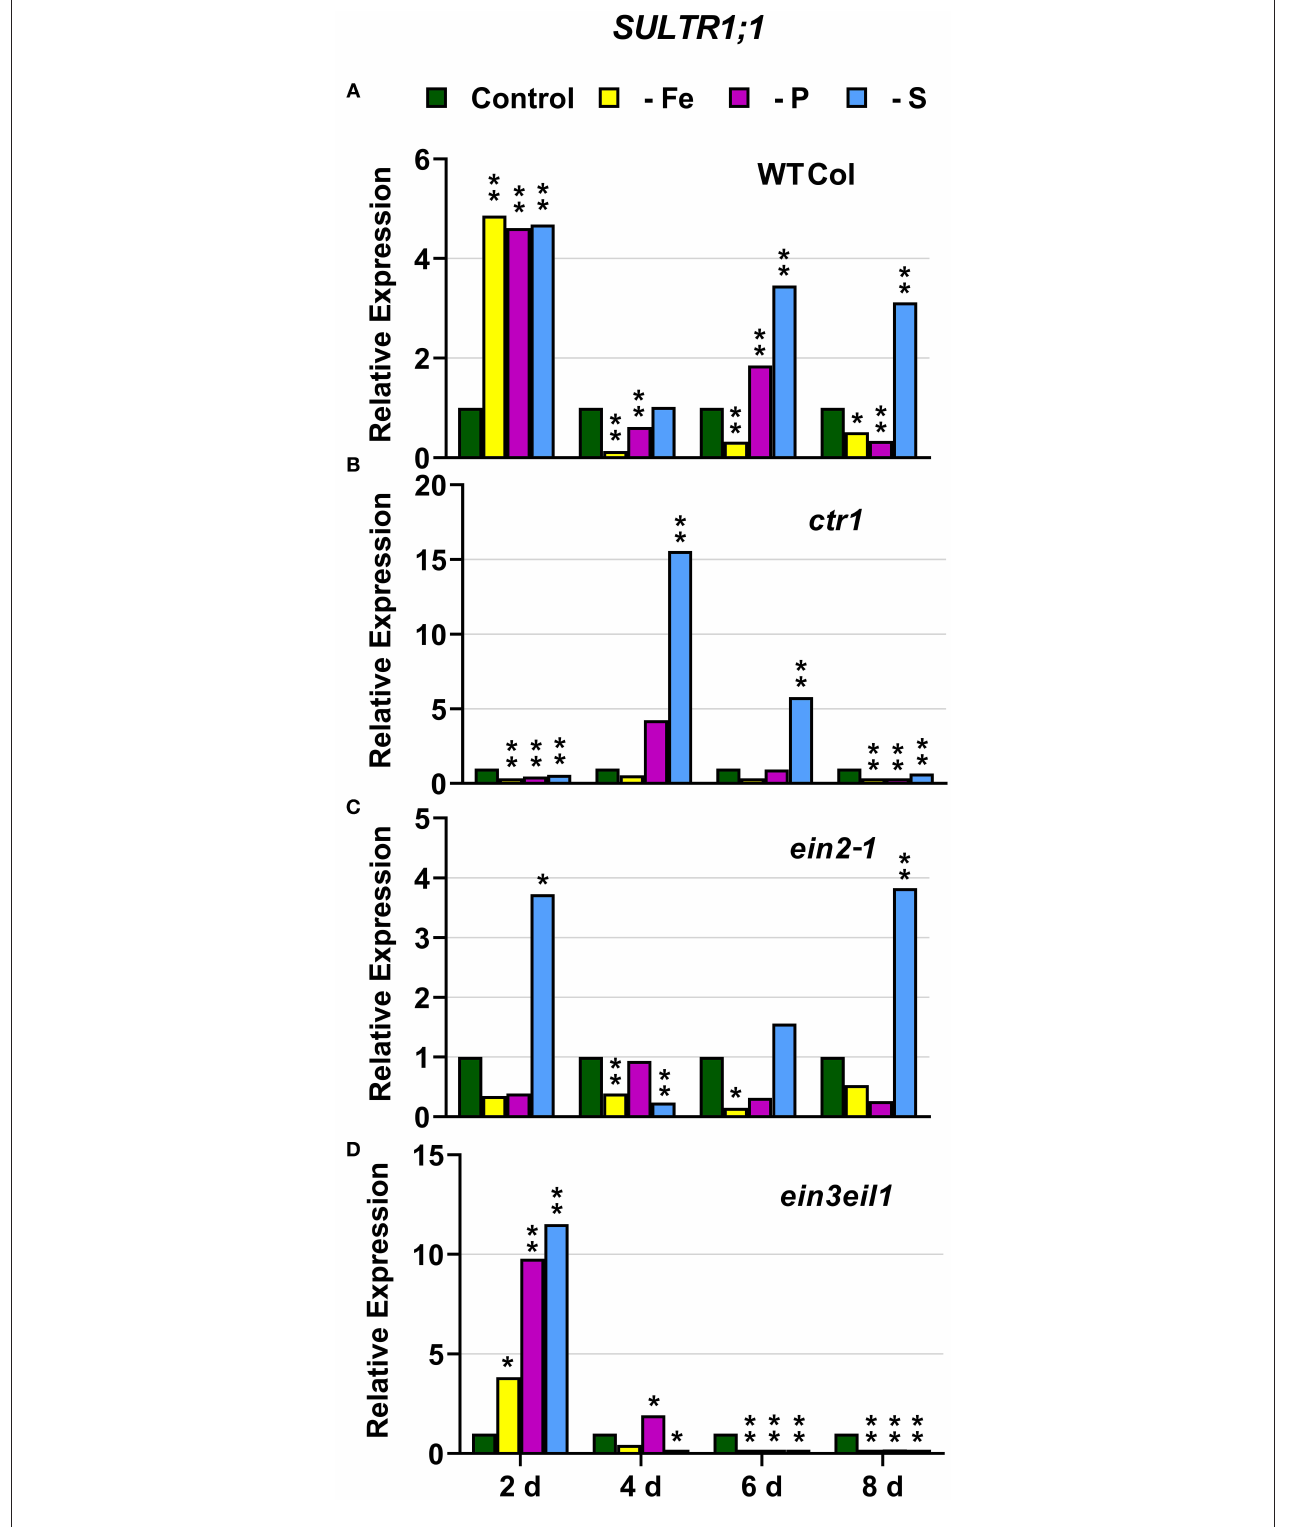
FIGURE 10 | Effect of Fe, P or S deficiency on the expression of the S-related gene SULTR1;1 in roots of the Arabidopsis WT Columbia and its ethylene mutants ctr1 , ein2-1 and ein3eil1 (A–D) . Treatments and gene expression determination as in Figure 1 . Within each day and genotype, * or ** indicate significant differences ( P < 0.05 or P < 0.01) in relation to the control